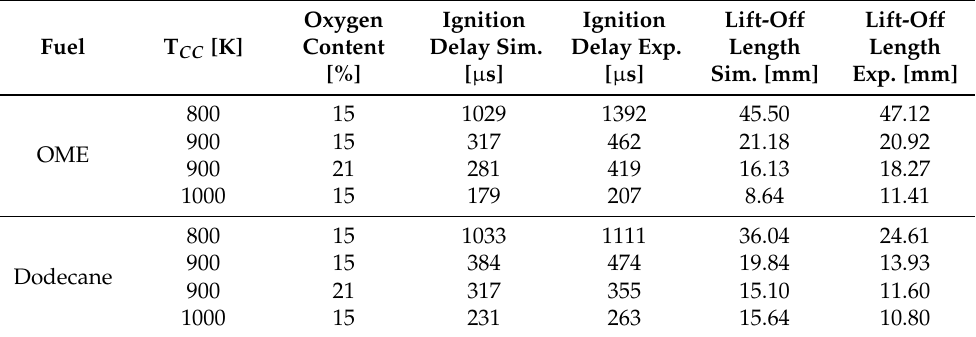
Figure 12. Conti3L: Lift-off length vs ignition delay for standard reaction mechanisms (OME: Niu [45], DOD: Yao [42]). ( left ) Multiple reaction mechanisms per fuel: Ar : T CC = 900 K, 15% O 2 . ( center ) O 2 content trends: T CC = 900 K, 15% O 2 ( Ar ) and 21% O 2 ( O2r ). ( right ) Temperature dependency: 15% O 2 , 800 K ( T2r ), 900 K ( Ar ) and 1000 K ( T3r ). Table 10. Conti3L: Ignition delay and lift-off length results for OME (mechanism: Niu [45]) and dodecane (mechanism: Yao